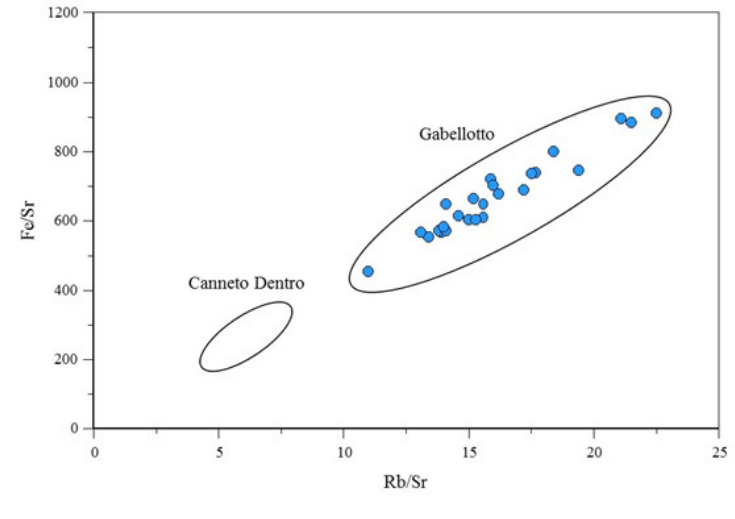
Figure 10. Graph of Fe, Rb, and Sr ratios showing assignment of all Lipari artifacts to Gabellotto using ellipses based on many geological samples analyzed with the same